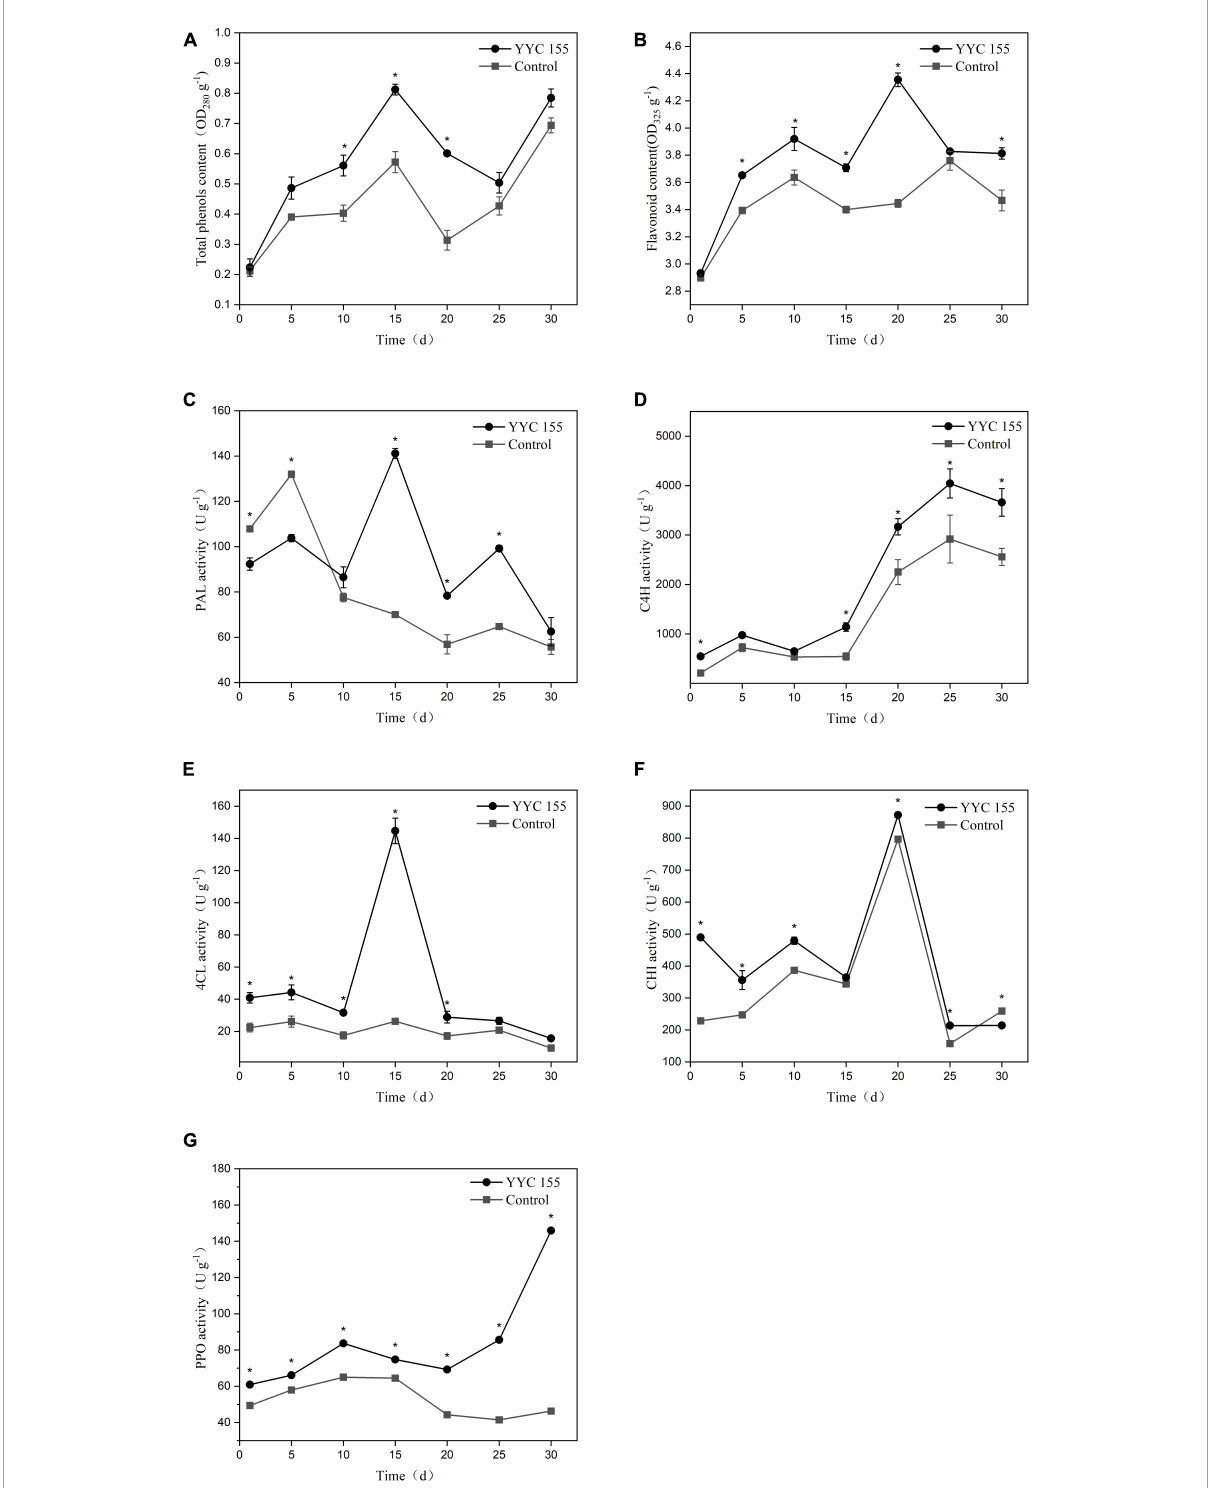
FIGURE10 Effect of B. tequilensis YYC 155 on the level of total phenols (A) and flavonoids (B) , and the activity of PAL (C) , C4H (D) , 4CL (E) , CHI (F) , and PPO (G) in C. oleifera . Three duplicates are used for the control and YYC 155 treatment C. oleifera leaves at each time point and were measured three times for each replicate. Data represent the mean ± standard error (se). Asterisks represent a significant difference between the two treatment groups at the designated timepoint as determined by the t -test ( P <